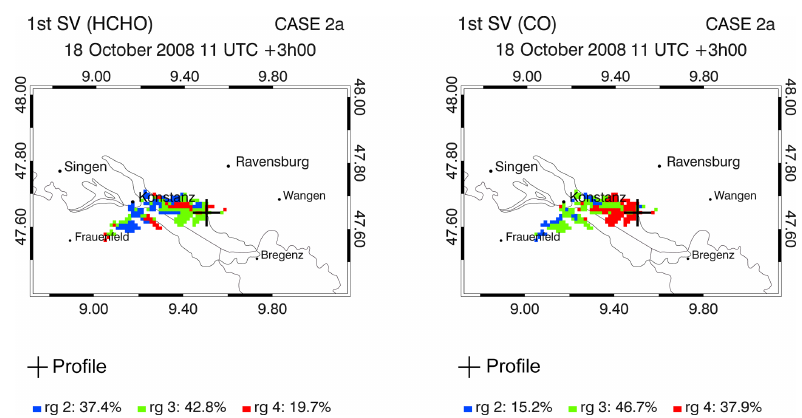
Figure 9. Spatially dependent measurement priorities of the first singular vector with respect to emission uncertainties. Illustrated are results for HCHO (left) and CO (right) at surface level for case 2a. Please note that the ranking is only depicted within the area of the relevance ranking. For each panel, the horizontal position of the final profile VP( t F ) is indicated with a black cross and the colour coding of each rank is denoted below each